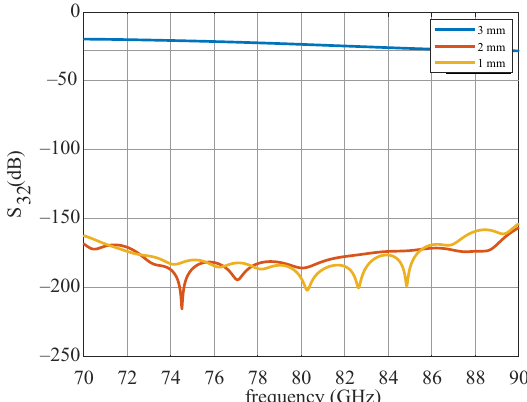
Figure 13. Simulation results of the transmission S 32 for three support structures.